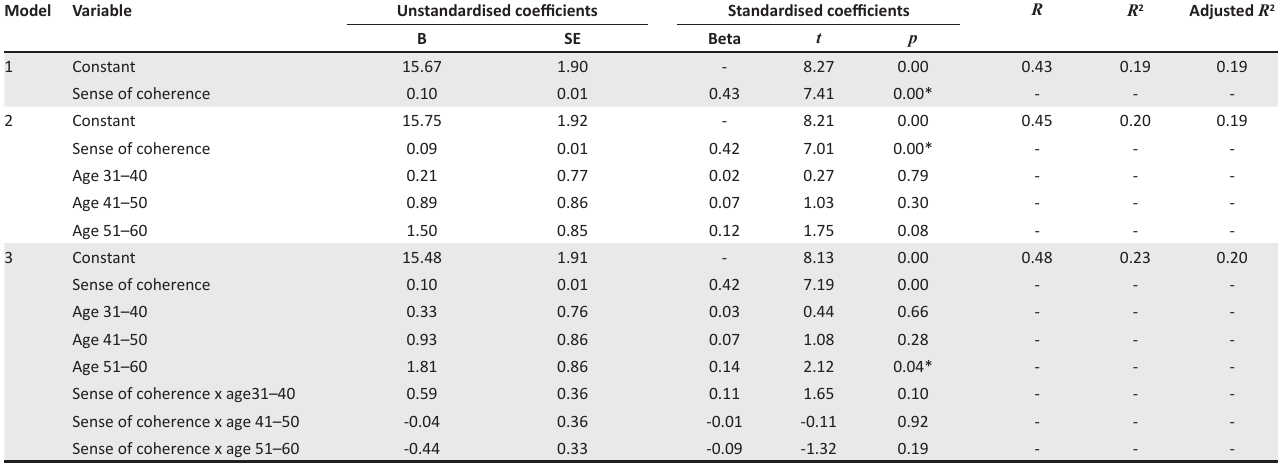
TABLE 6: Moderated multiple regression with professional efficacy as the dependent variable. Model